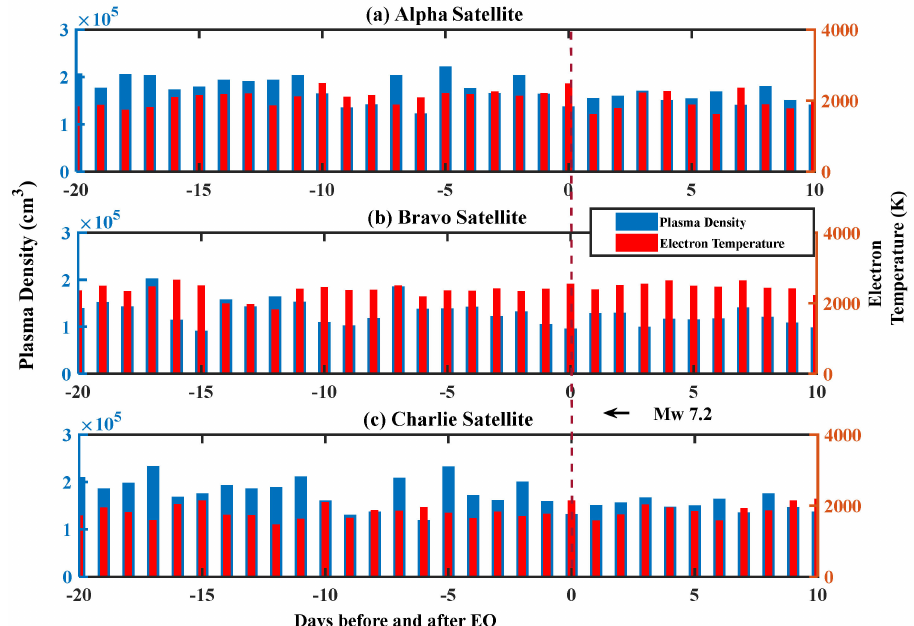
Figure 12. Comparison of daily values from Swarm ( a – c ) for M w 7.2 (Haiti) EQ. The plasma density values are shown in blue, and Electron Temperature (ET) is shown by red bar lines, and the red dashed line represents the EQ day.